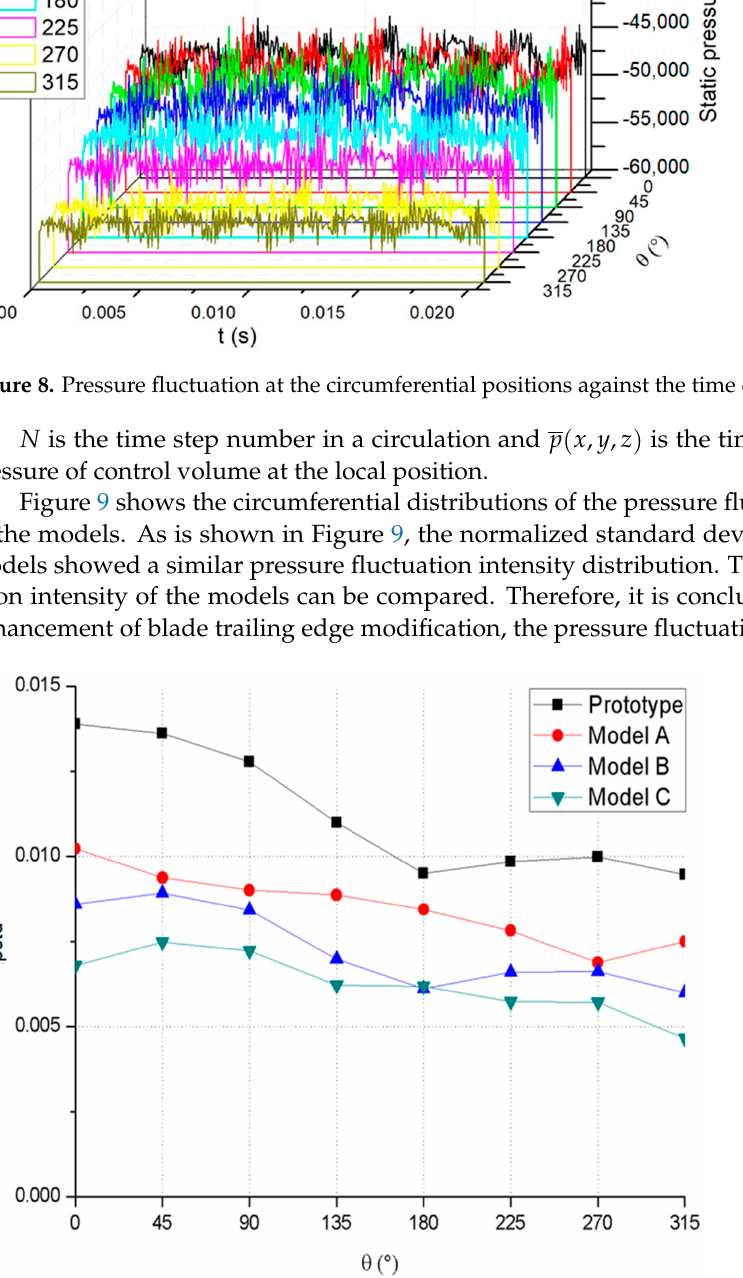
Figure 9. Circumferential distributions of the pressure fluctuation intensity.